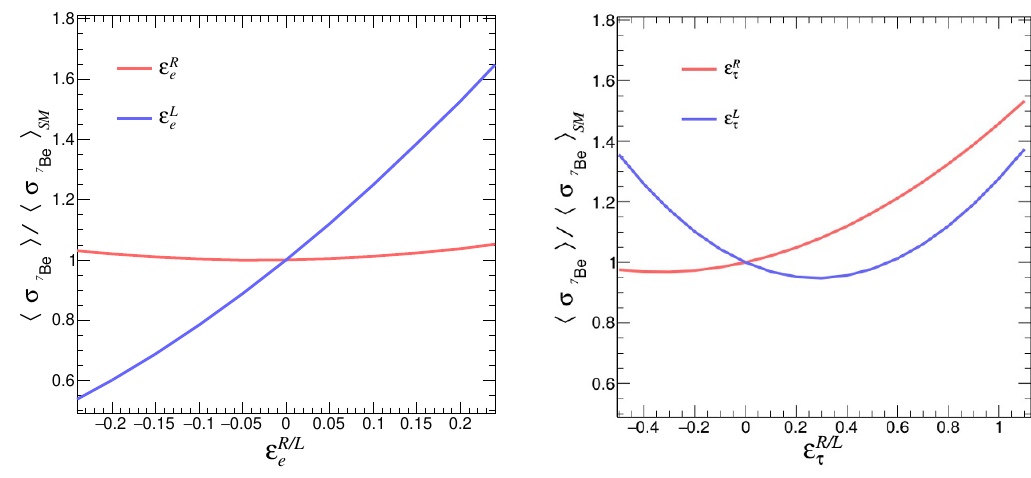
Figure 3 . The relative change of the total cross section ratio h (cid:27) 7 (left panel) and " R=L (cid:28) (right